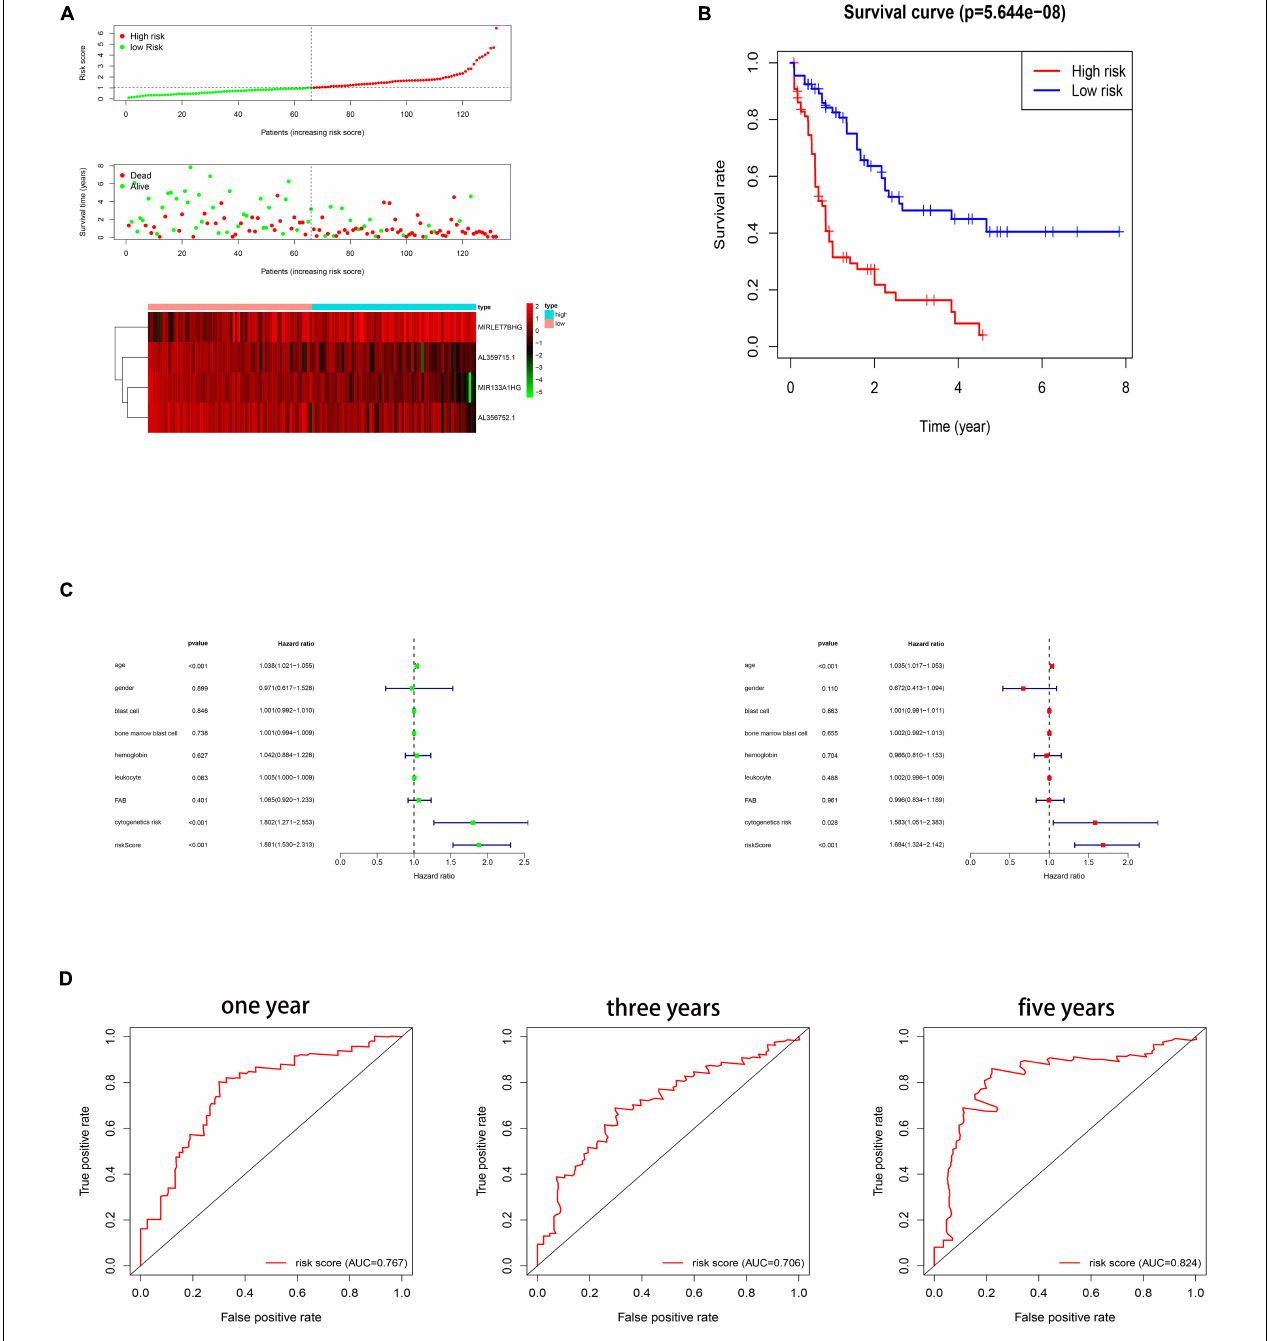
FIGURE 2 | (A) Risk scores and survival status of AML patients. Heat map depicting the different expressions of the four lncRNAs in AML patients. (B) Kaplan–Meier survival curve for the signature. (C) Cox regression. (D) ROC curves for 1 year, 3 years, and 5 years.